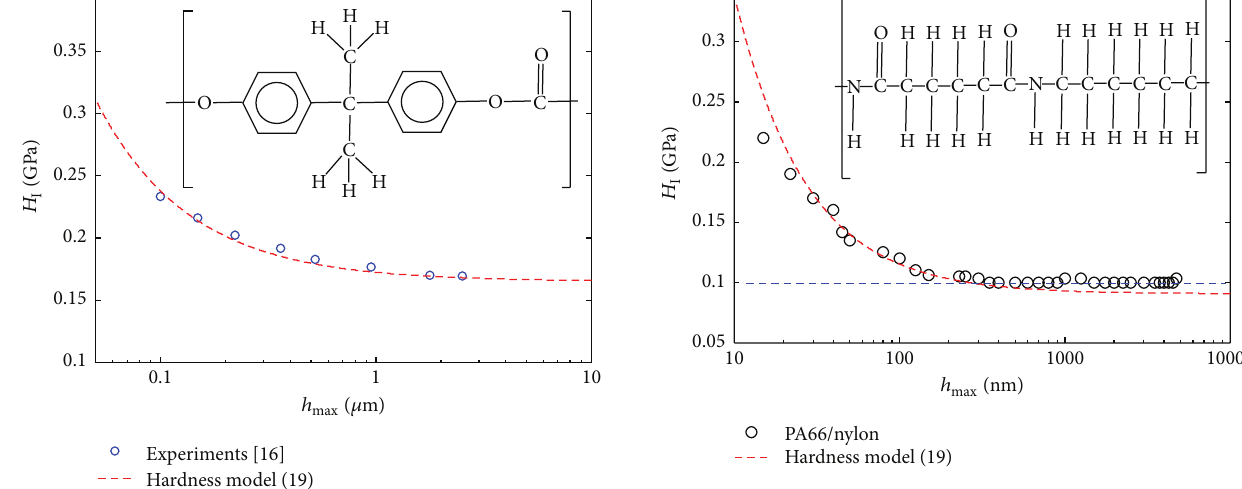
Figure 32: Indentation hardness of PC [16] and its molecular structure [68].